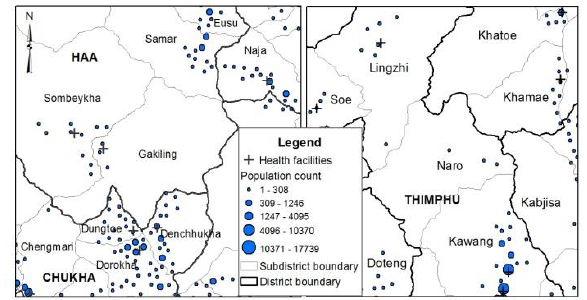
Figure 9: Distribution of population clusters and health facilities for Gakiling and Naro sub-districts